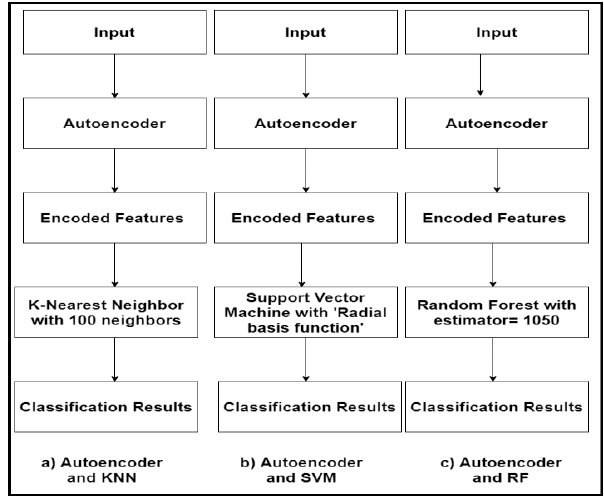
Figure 7. The hybrid autoencoder-based machine learning classifier. KNN: K-nearest neighbour; RF: random forest.